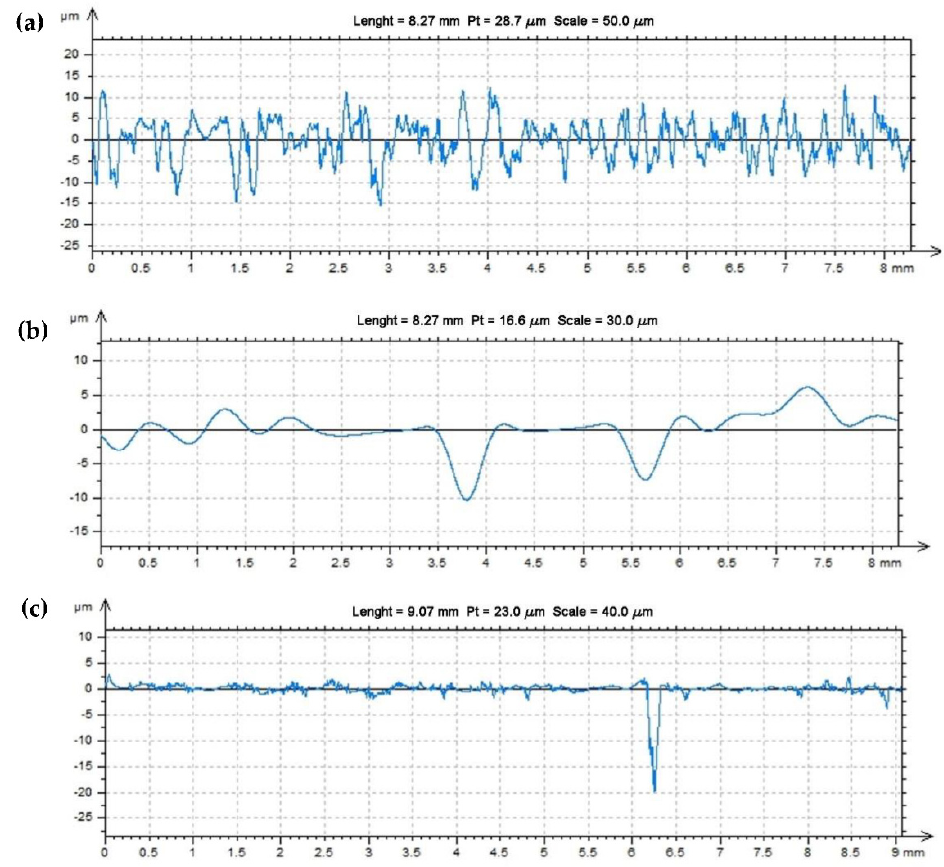
Figure 12. The roughness Ra profile parameter—sample ( a ), 100% resin; sample ( b ), 5% resin and 95% brass; sample ( c ), 5% resin and 95% aluminum.